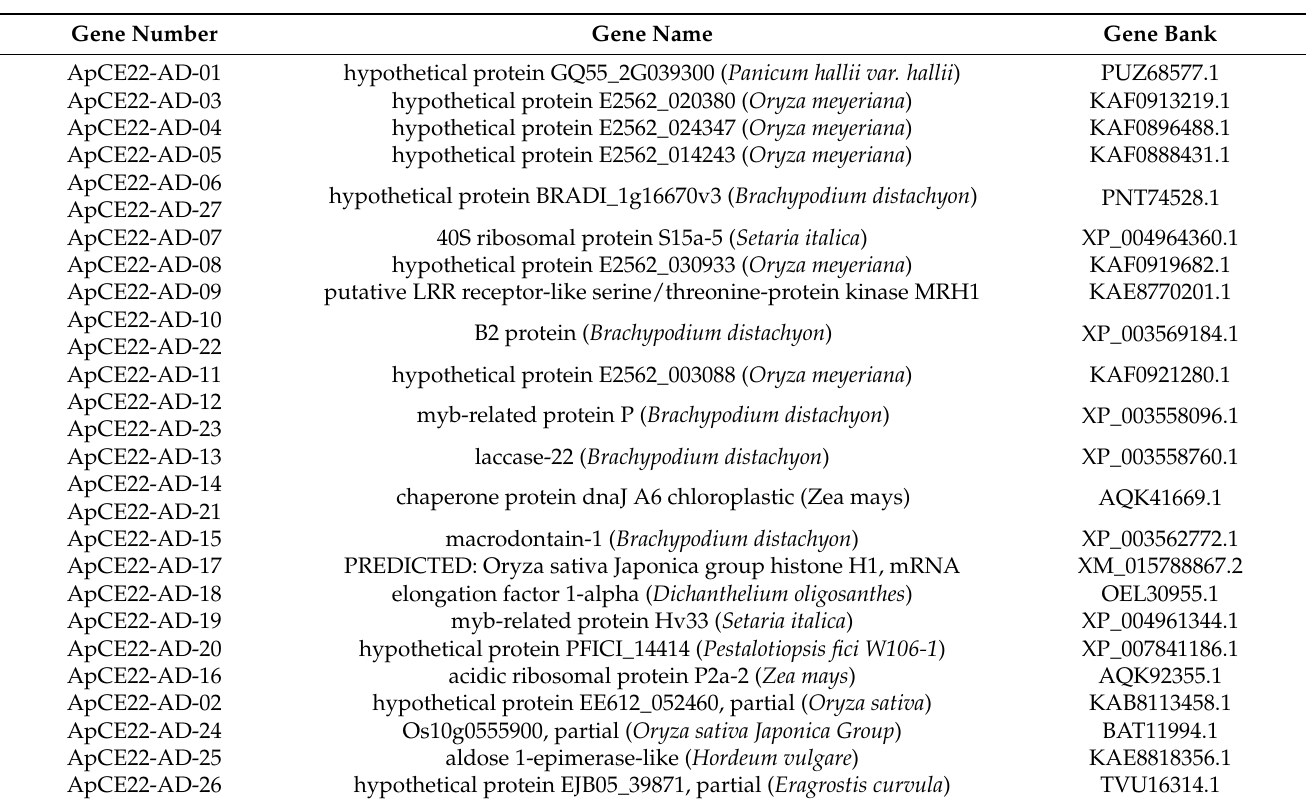
Table 2. Functional annotation of target gene of effector ApCE22